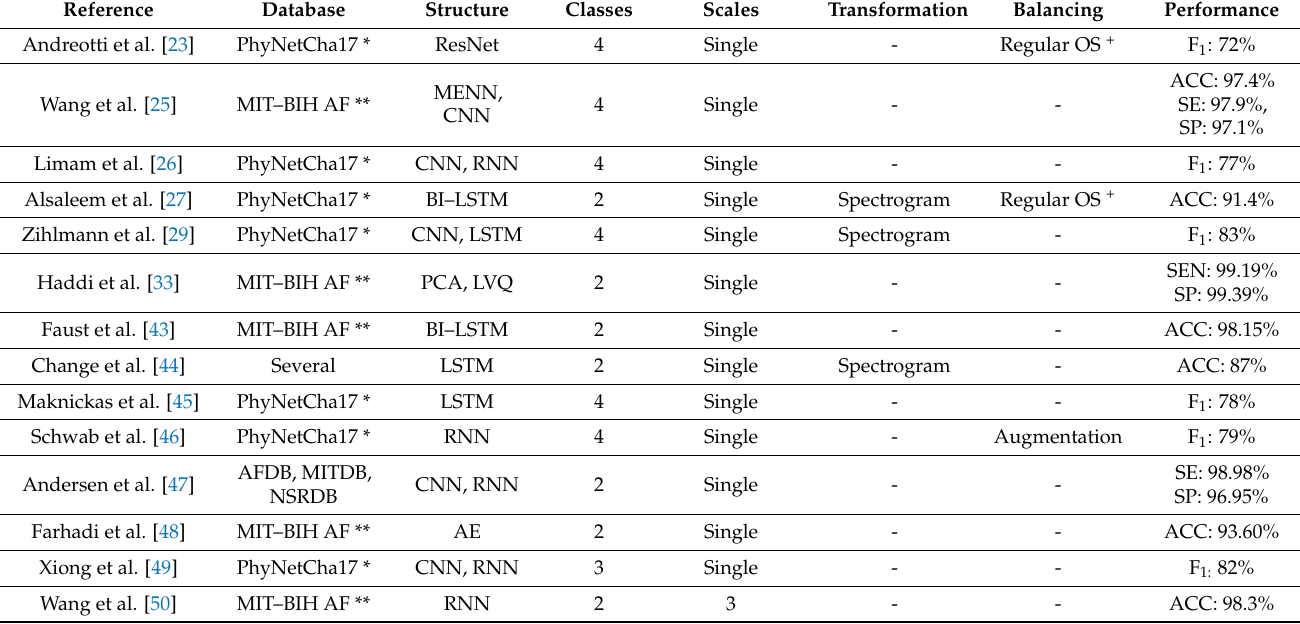
Table 2. State-of-the-art atrial fibrillation (AF) detection methods using hybrid models with respect to the database, structure, classes, scales, transformation, balancing type, and